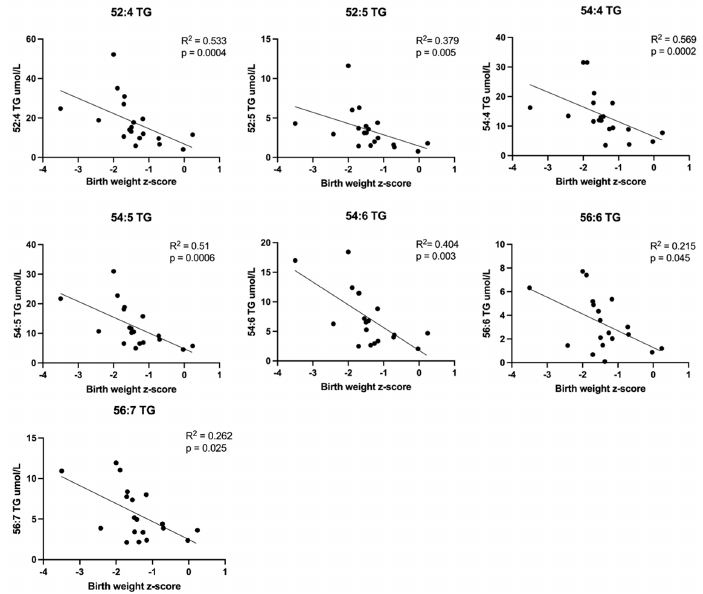
Figure 5. Correlations between umbilical vein plasma lipid concentrations and birth weight z–score : triglycerides. Scatterplots demonstrate the correlation relationships between birth weight z-score and plasma triglyceride concentrations containing higher numbers of carbon atoms and double bonds most likely to contain long chain polyunsaturated fatty acids. Spearman’s rank correlation was computed to assess relationships.